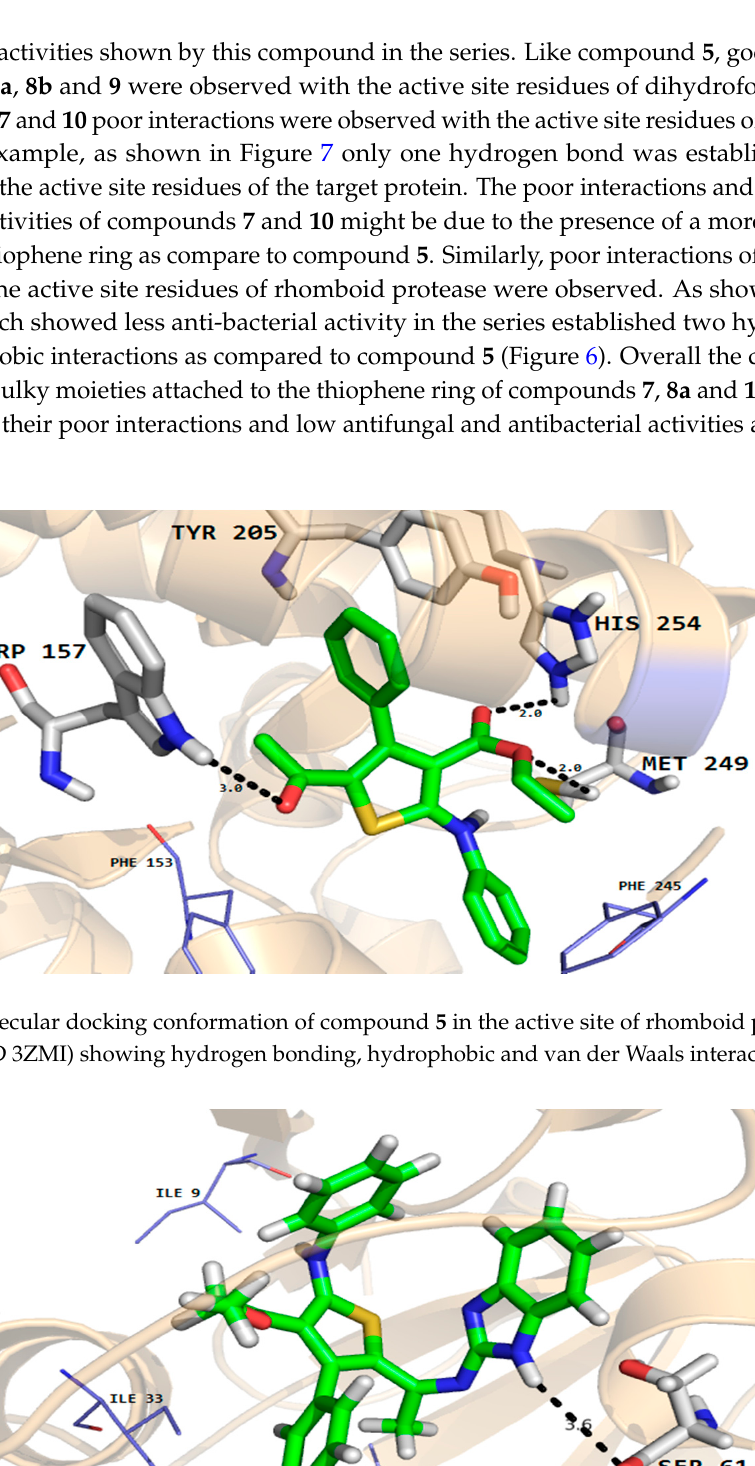
Figure 7. Molecular docking conformation of compound 7 in the active site of C. albicans dihydrofolate reductase protein (PDB ID 4HOF) showing hydrogen bonding, hydrophobic and van der Waals interactions.